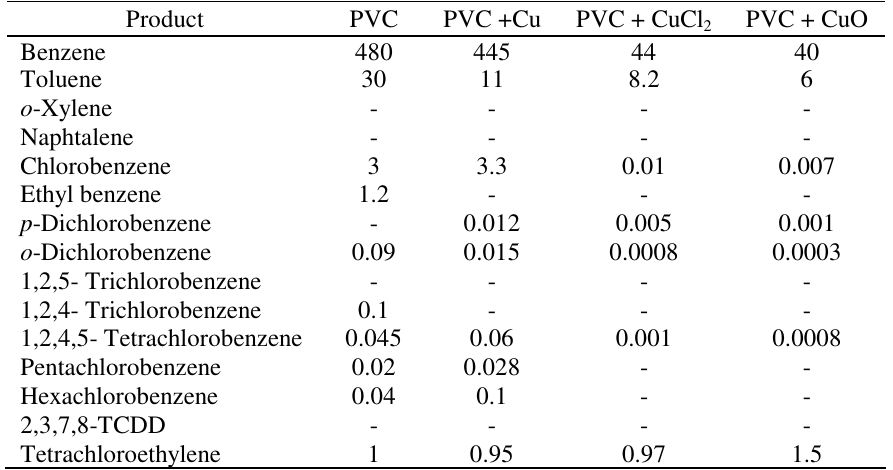
Table 7 . The amount ( µ g) of organic gases products from the combustion of pure PVC and mixture of PVC with copper, copper(II) chloride and cupric oxide at 300 ° C under nitrogen.